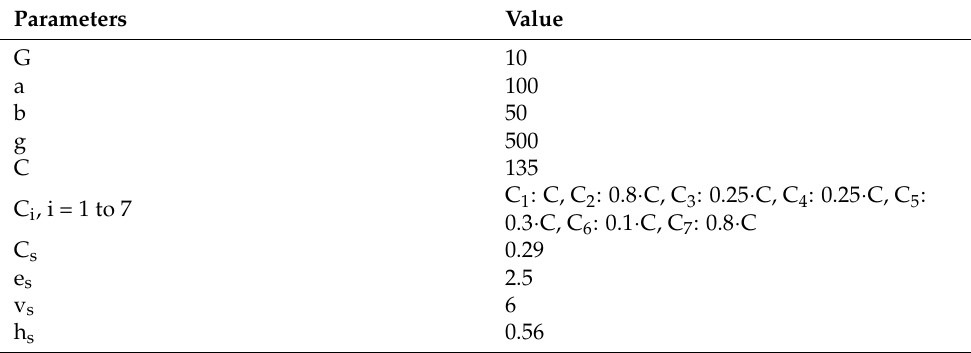
Table A1. Parameters for the mathematical seizure model of hippocampus in